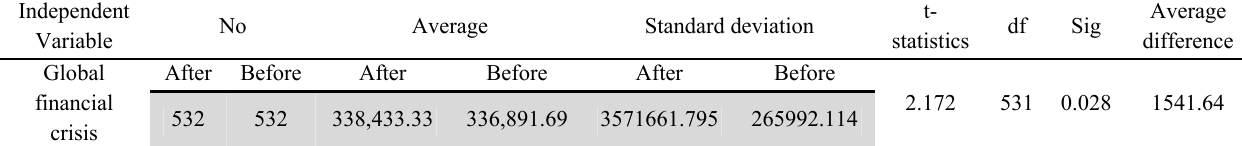
The results of the t-test on relationship between global financial crisis and stock prices of the